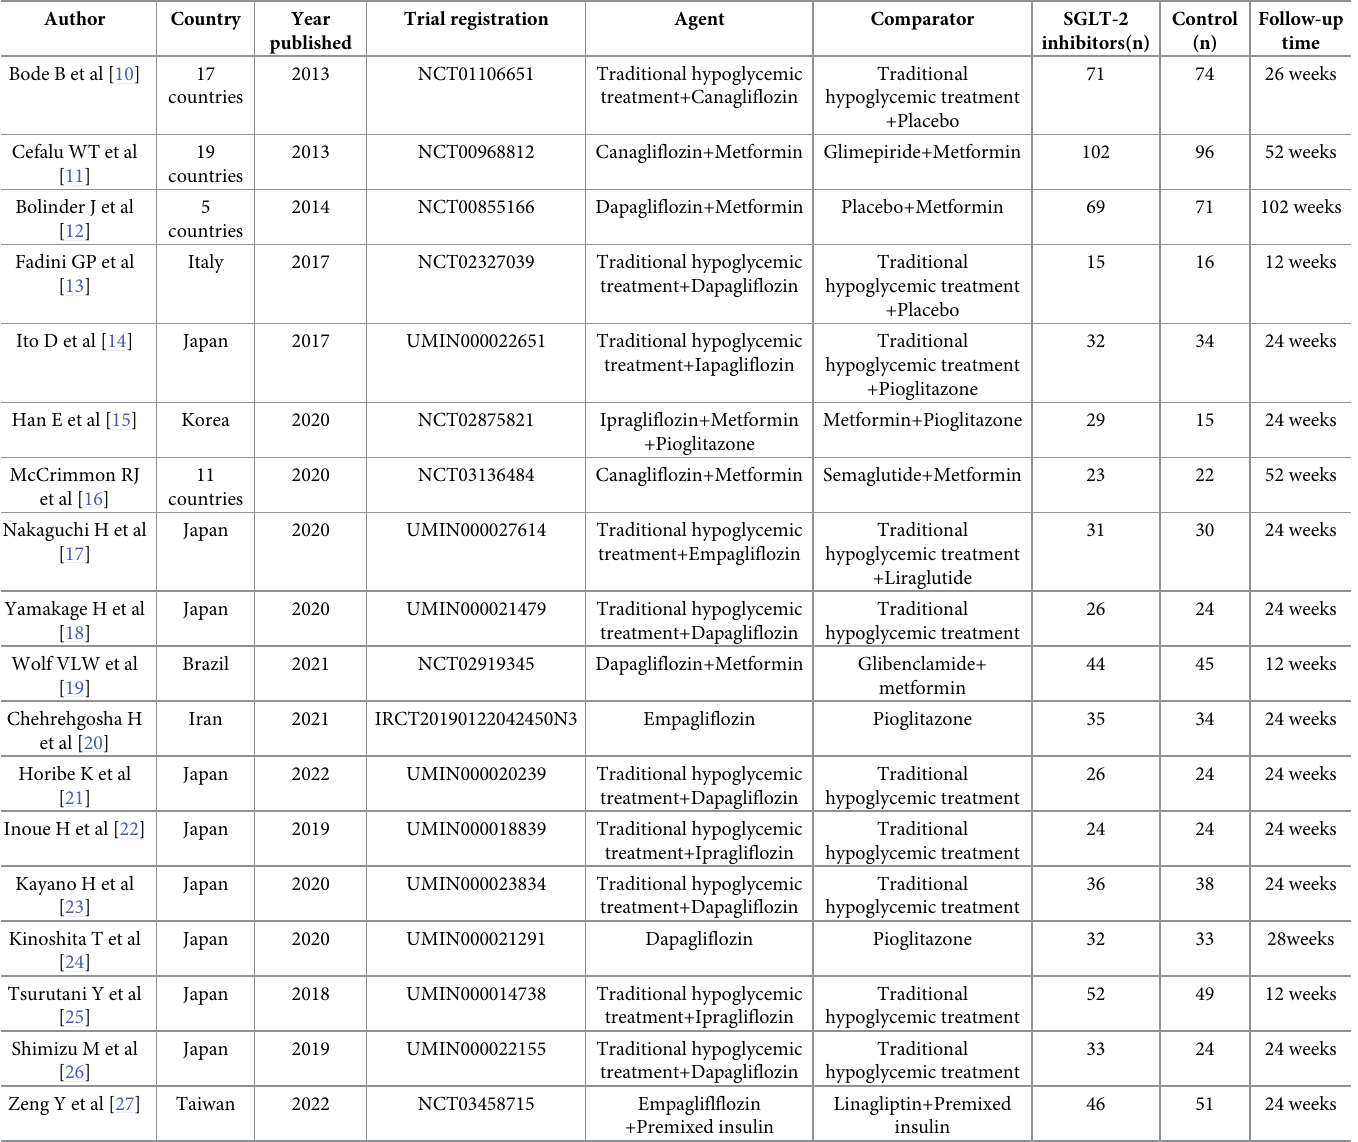
Table 1. Demographic and clinical characteristics of included